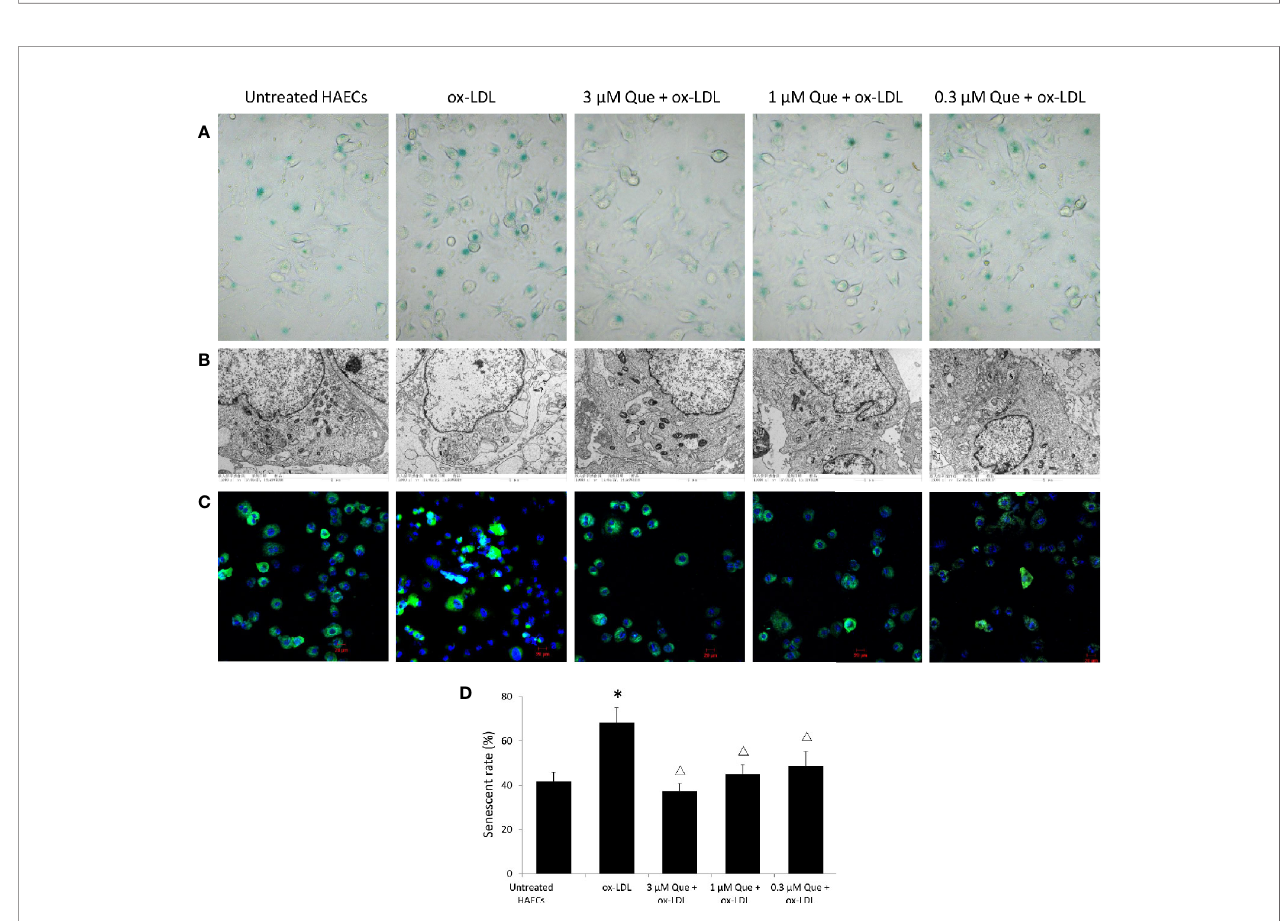
FIGURE 1 | Quercetin alleviated atherosclerotic lesion in vivo . (A) Oil red O staining of entire arterial tree to assess lipid deposition and atherosclerotic lesion of mice (n = 3). (B) Quanti fi cation of the gross lesion areas in the entire arterial tree (n = 3). (C) Serum soluble Icam-1 level was determined by enzyme-linked immunosorbent assay (ELISA) assay (n = 7). (D) Serum IL-6 level was determined by ELISA assay (n = 7). (E) the representative photograph and semi-quantitative analysis of IHC of density of Vcam-1 and Sirt1 in aorta (n = 3). The sites in brown-yellow colour were judged as positive (× 400). * P < 0.05, vs C57 mice; Δ P < 0.05, vs ApoE -/- mice.